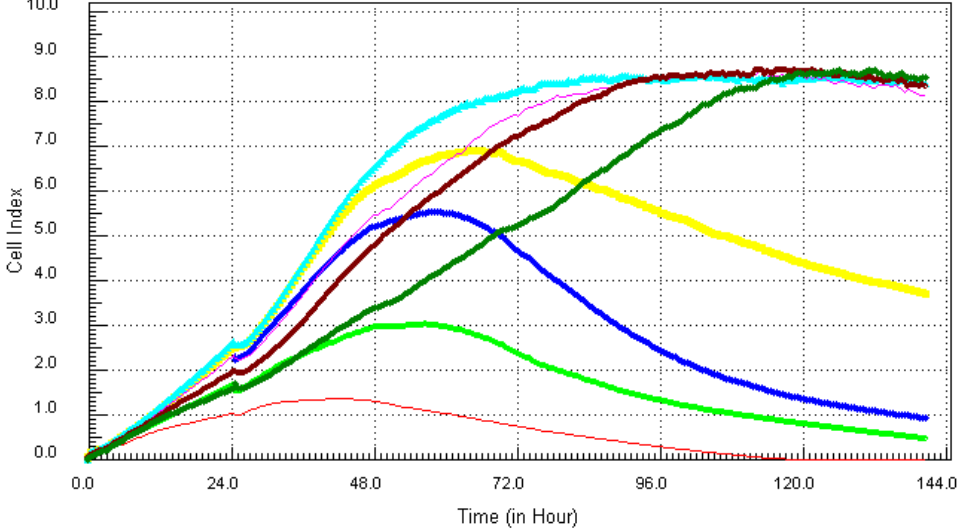
Figure 5. Kinetics of cytotoxic responses for mixture (Mix) in MCF7 as described in Figure 1